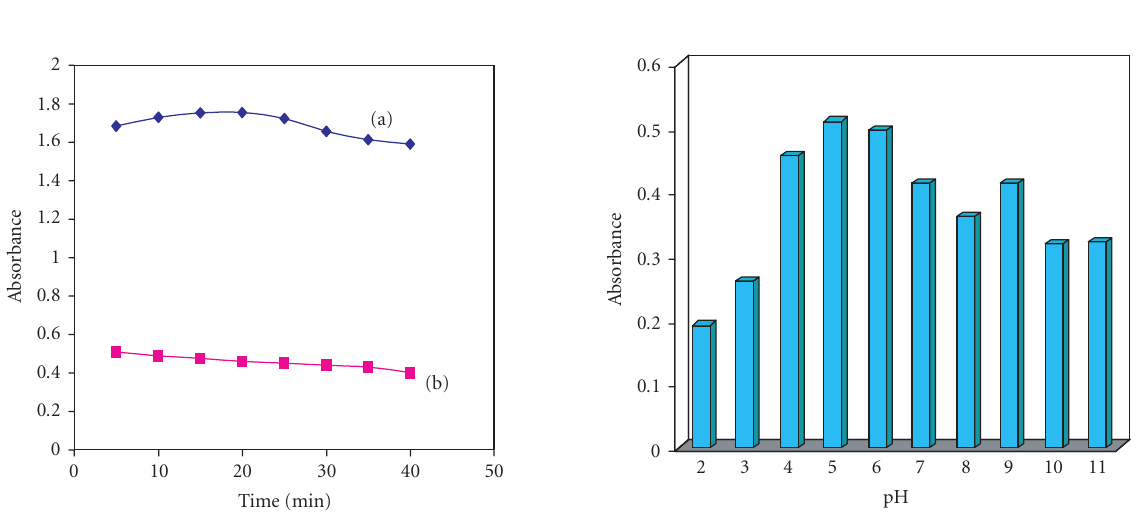
Figure 5. Clustered column showing relation between pH and absorbance in case of LD with iodine compound at wavelength =